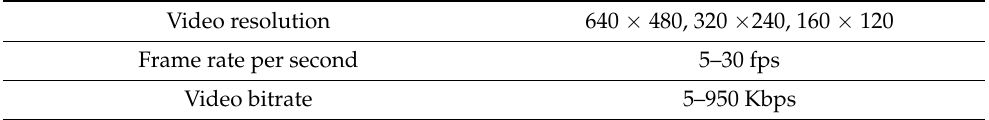
Table 2. Skype video codec